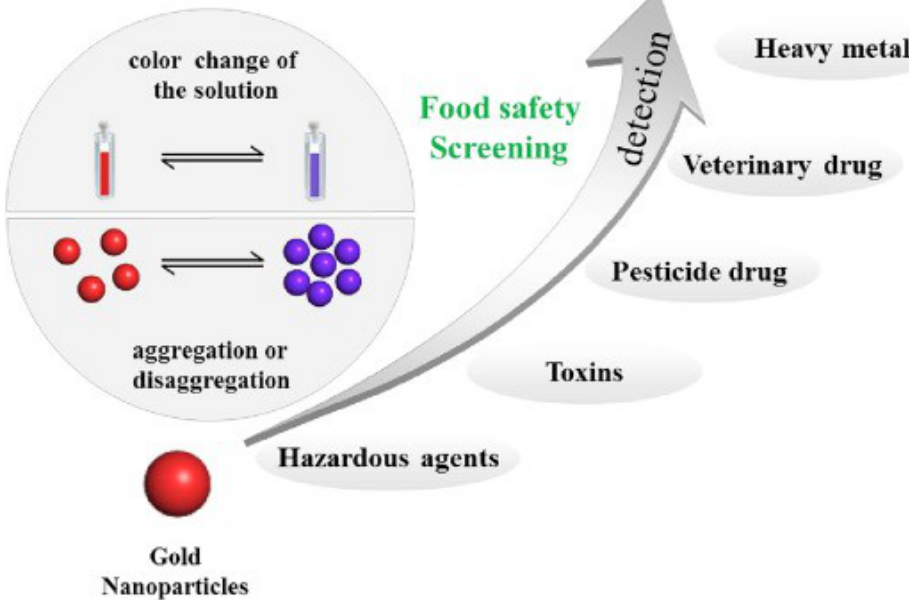
Figure 1. Application of gold nanoparticle colorimetric sensors in food safety screening. Reproduced with permission from reference [30].